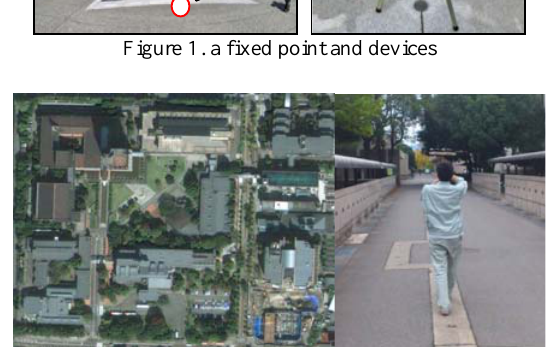
Figure 2. place on a walk and devices